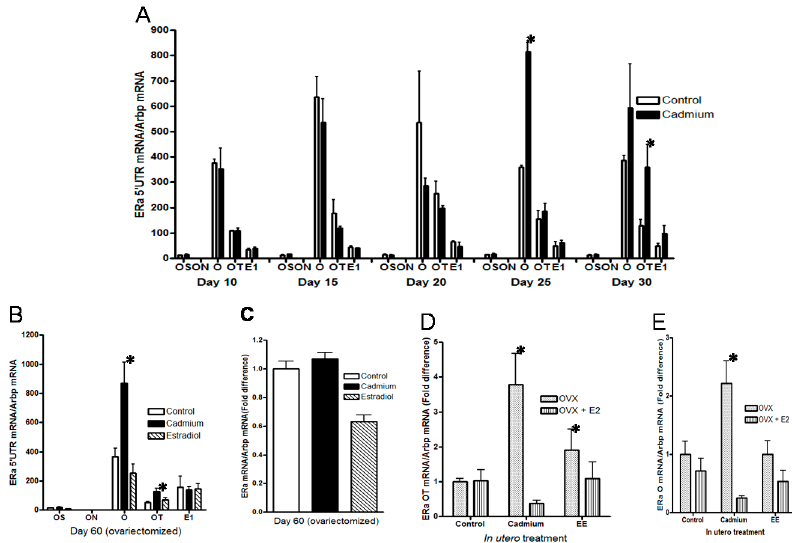
Figure 5. Effects of in utero exposure to cadmium on the expression of ER α transcripts in the mammary gland of female offspring. Pregnant female rats were treated with cadmium (5 μ g/kg bw) or ethinyl estradiol (50 μ g/kg bw) as described in Figure 1 and the female offspring were examined. ( A ) in utero effects on ER α transcripts in the prepubertal mammary gland. The amount of the5’ untranslated RNA (5 ′ UTR) ER α mRNA was measured on postnatal days 10, 15, 20, 25, and 30 by qRT-PCR and normalized to Arbp mRNA (mean ± SEM; n = 2–3 offspring/group; * p < 0.05); ( B ) in utero effects on ER α transcripts in the adult mammary gland. Female offspring were ovariectomized on postnatal day 45. On postnatal day 60, the amount of ER α 5 ′ UTR transcript was measured by a qRT-PCR assay and normalized to Arbp mRNA (mean ± SEM; n = 7–12 offspring/group; * p < 0.05); ( C ) in utero effects on ER α gene transcription in the adult mammary gland. Female offspring were ovariectomized on postnatal day 45, nuclei were isolated on postnatal day 60, and a nuclear run on assay was performed. The amount of the nascent ER α transcript was measured by qRT-PCR, normalized to Arbp transcript, and presented as fold difference ( n = 8–10 offspring); ( D , E ) in utero effects on the regulation of ER α transcripts in the adult mammary gland. Female offspring were ovariectomized on postnatal day 45 and treated for four days with 17 β -estradiol beginning on postnatal day 56. On postnatal day 60, the amount of O and OT transcripts was measured by a qRT-PCR assay, normalized to Arbp mRNA, and presented as fold difference (mean ± SEM; n = 7–11 offspring/group; * p < 0.05).